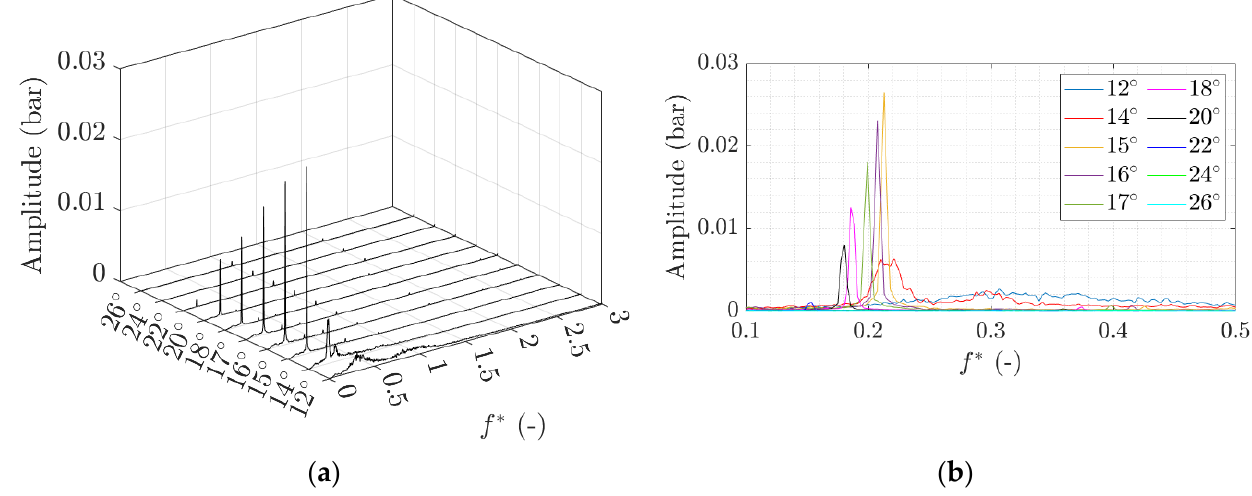
Figure 5. Spectra of the RM pressure signals calculated with Equation (4) using P1x 0° and P1x 180° at α from 12° to 26° ( a ) and zoomed in around RM peak ( b ).